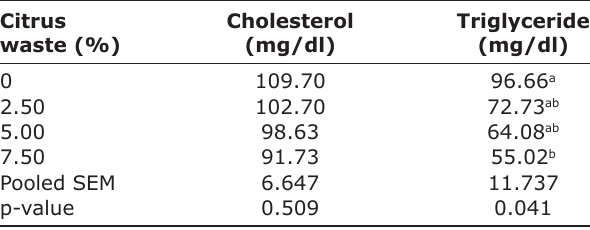
Table-2: Effect of feeding different levels of citrus waste on the lipid profile of blood in broiler. Citrus waste (%)